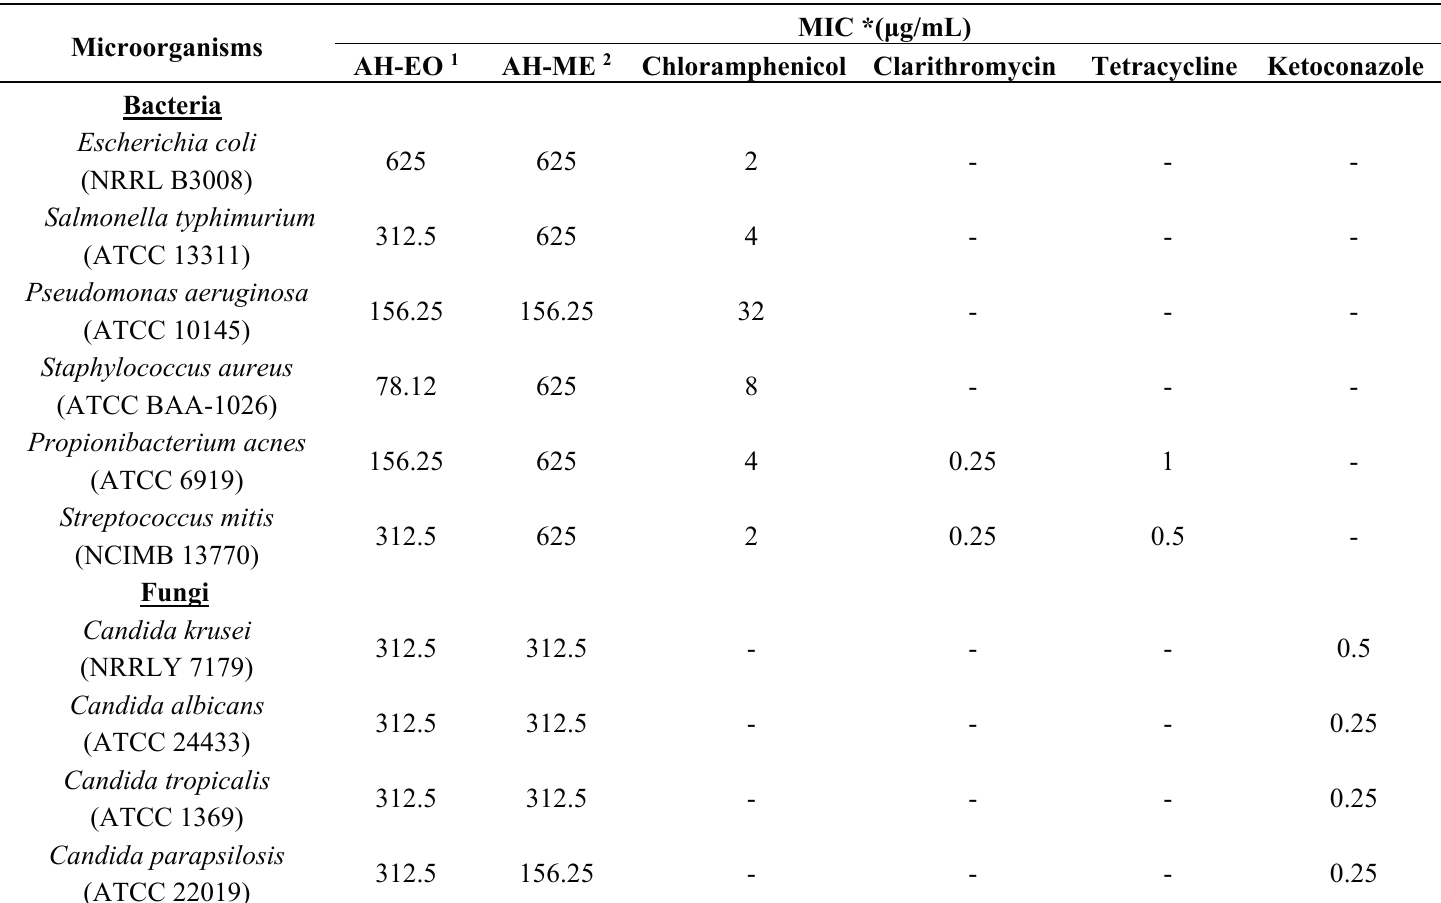
Table 3. Antimicrobial activity of essential oil and methanol extract of A.